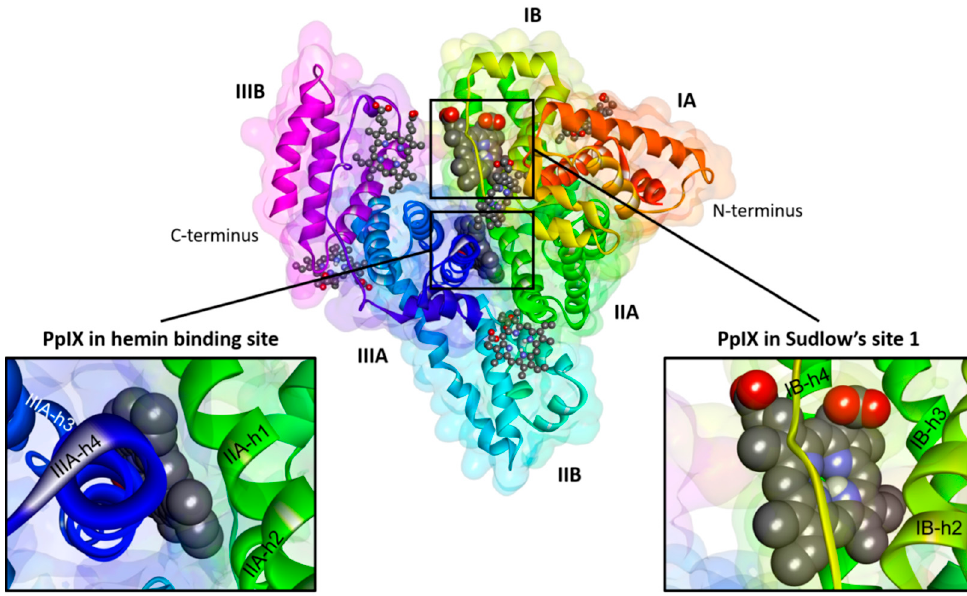
Figure 8. Macromolecule of HSA (PDB 1AO6) complexed with the PpIX molecules. The protein backbone is shown schematically as a ribbon. Each subdomain of HSA is marked according to the model proposed by Carter and Ho [14]. The best docking results (number 1 and 2) are shown in the CPK representation. Other docking results are shown in the ball and stick representation. For the sake of clarity, only polar hydrogen atoms are displayed.